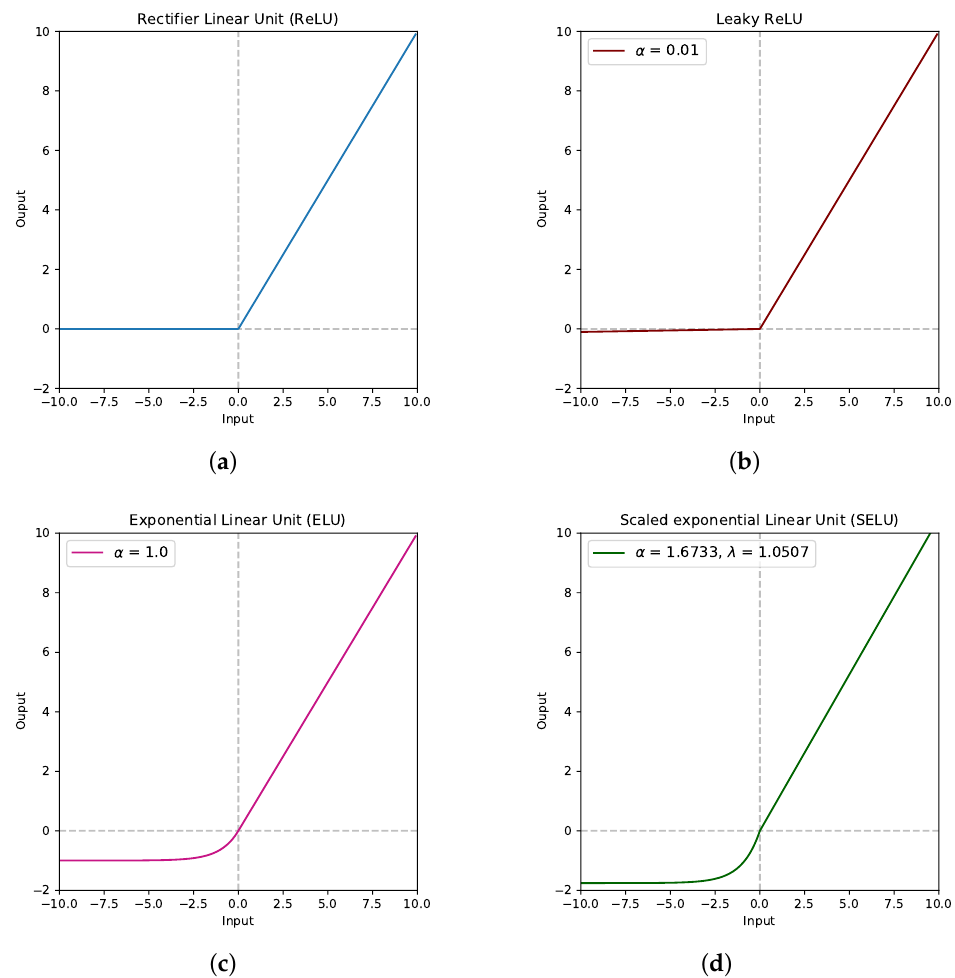
Figure 20. Variants of activation functions. ( a ) ReLU. ( b ) Leaky ReLU. ( c ) ELU. ( d ) SELU.